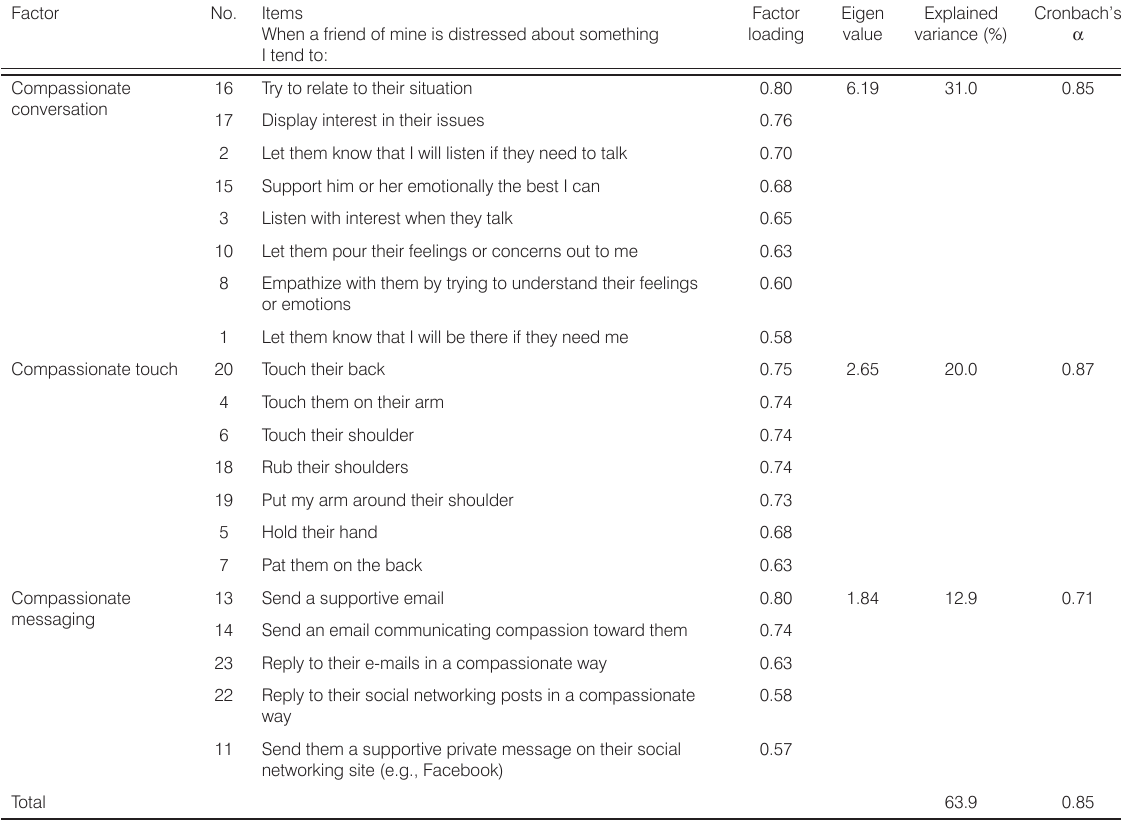
Table 2. Factor loading from Compassionate Communication scale ( N =